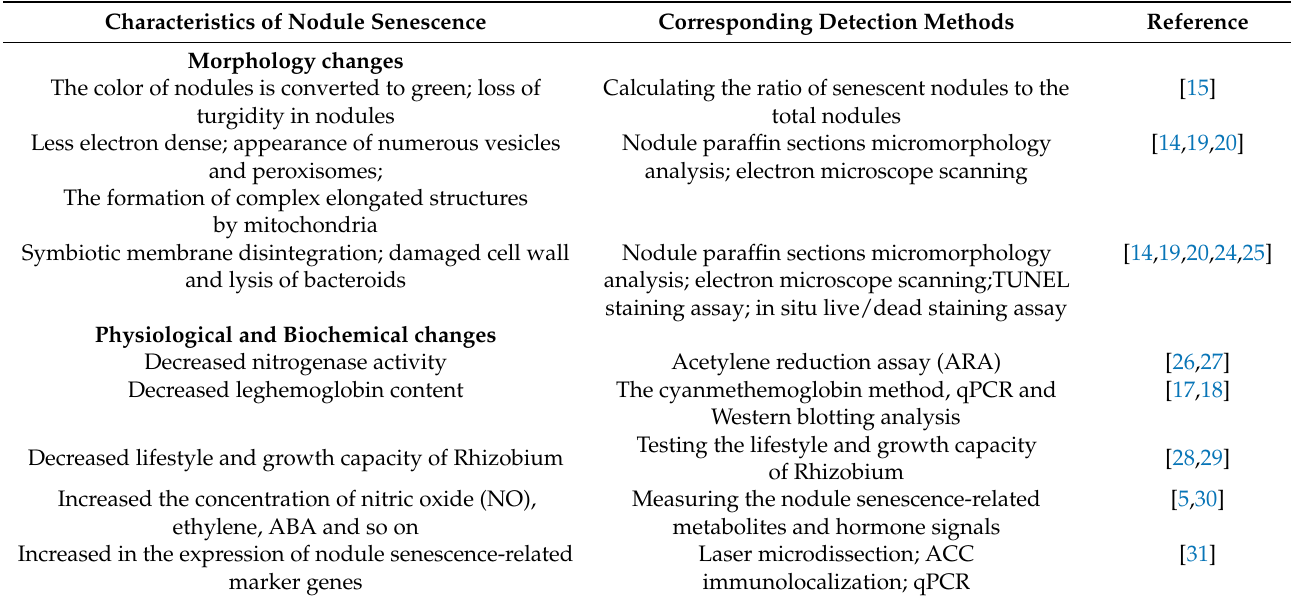
Table 1. The morphology, physiological and biochemical changes of legume nodule senescence and the corresponding detection